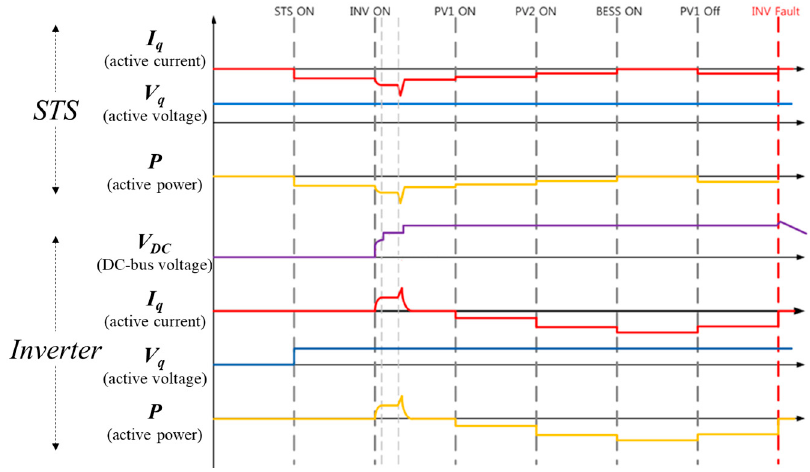
Figure 9. Test sequence.